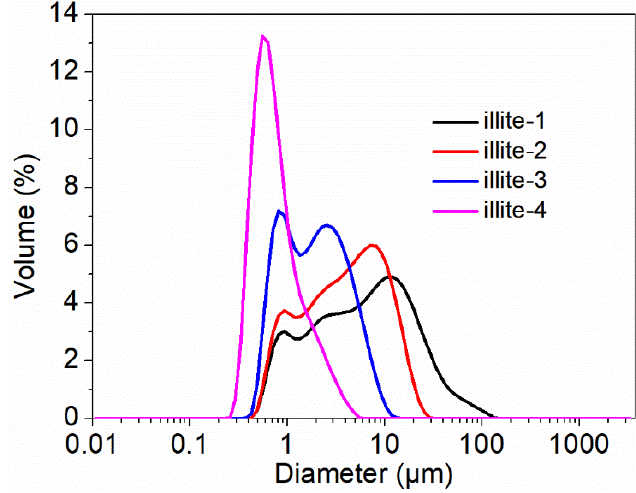
Figure 1. The particle size distribution of illite samples. Table 2. Parameters of four different illite particles.